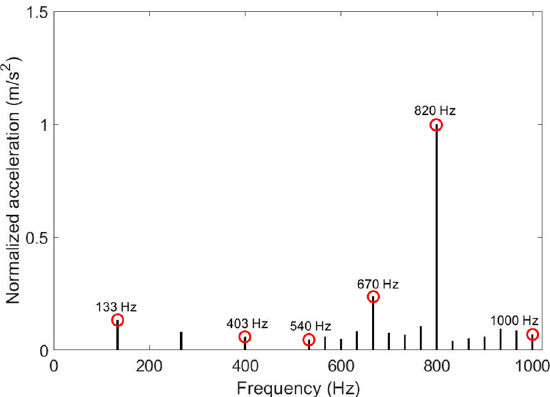
6 of 16 Figure 5. Finite element model of the BLDC motor. Figure 6. Normalized acceleration and peak frequencies of the finite element BLDC motor model. The vibration measurement data in Figure 7 were used to verify the EM–structural coupled analysis results [26]. Table 2 summarizes the relative errors of the peak frequen- cies of the EM–structural coupled analysis and the vibration measurement results. The